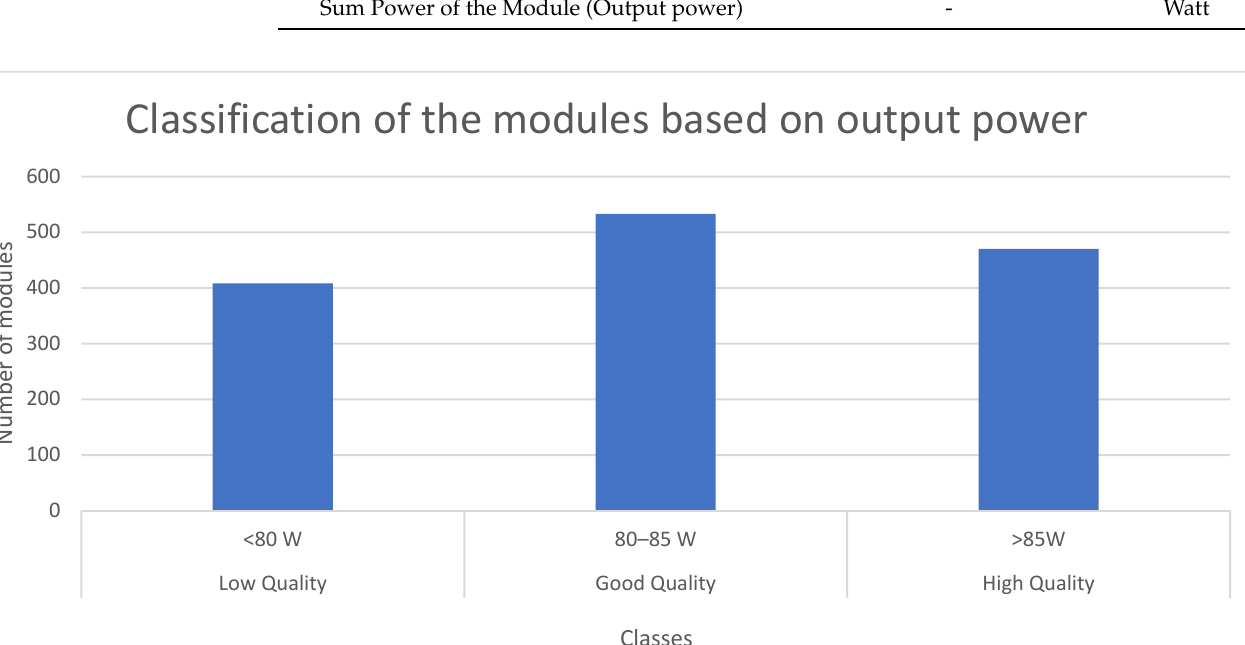
Table 3. Important input variables of the d-serie laser module.